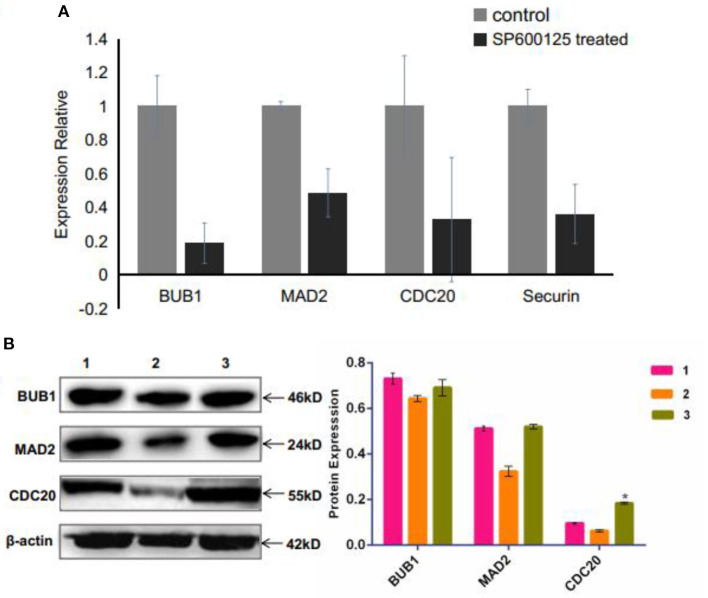
Effects of SP600125 on the expression levels of spindle assembly checkpoint genes. (A) qRT-PCR analysis for the differentially expressed BUB1, MAD2, and CDC20 genes between the control group and the SP600125-treated cells. (B) Western blot analysis of expression levels of BUB1, MAD2, and CDC20 upon SP600125 treatment, where “1” represents the cells in the control group (without SP600125), “2” stands for the cells treated by SP600125 for 48 h, and “3” represents the cells first being treated by SP600125 for 48 h, then by SP600125-free culture for the next 12 h, and further by SP600125 treatment for another 48 h. Each bar represents the mean ± SD of three independent experiments (*P < 0.05).